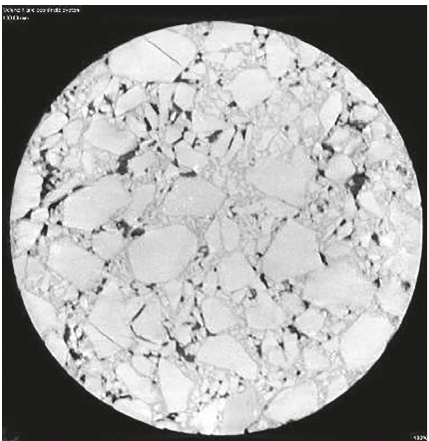
Figure 1: Original image of CT scanning.